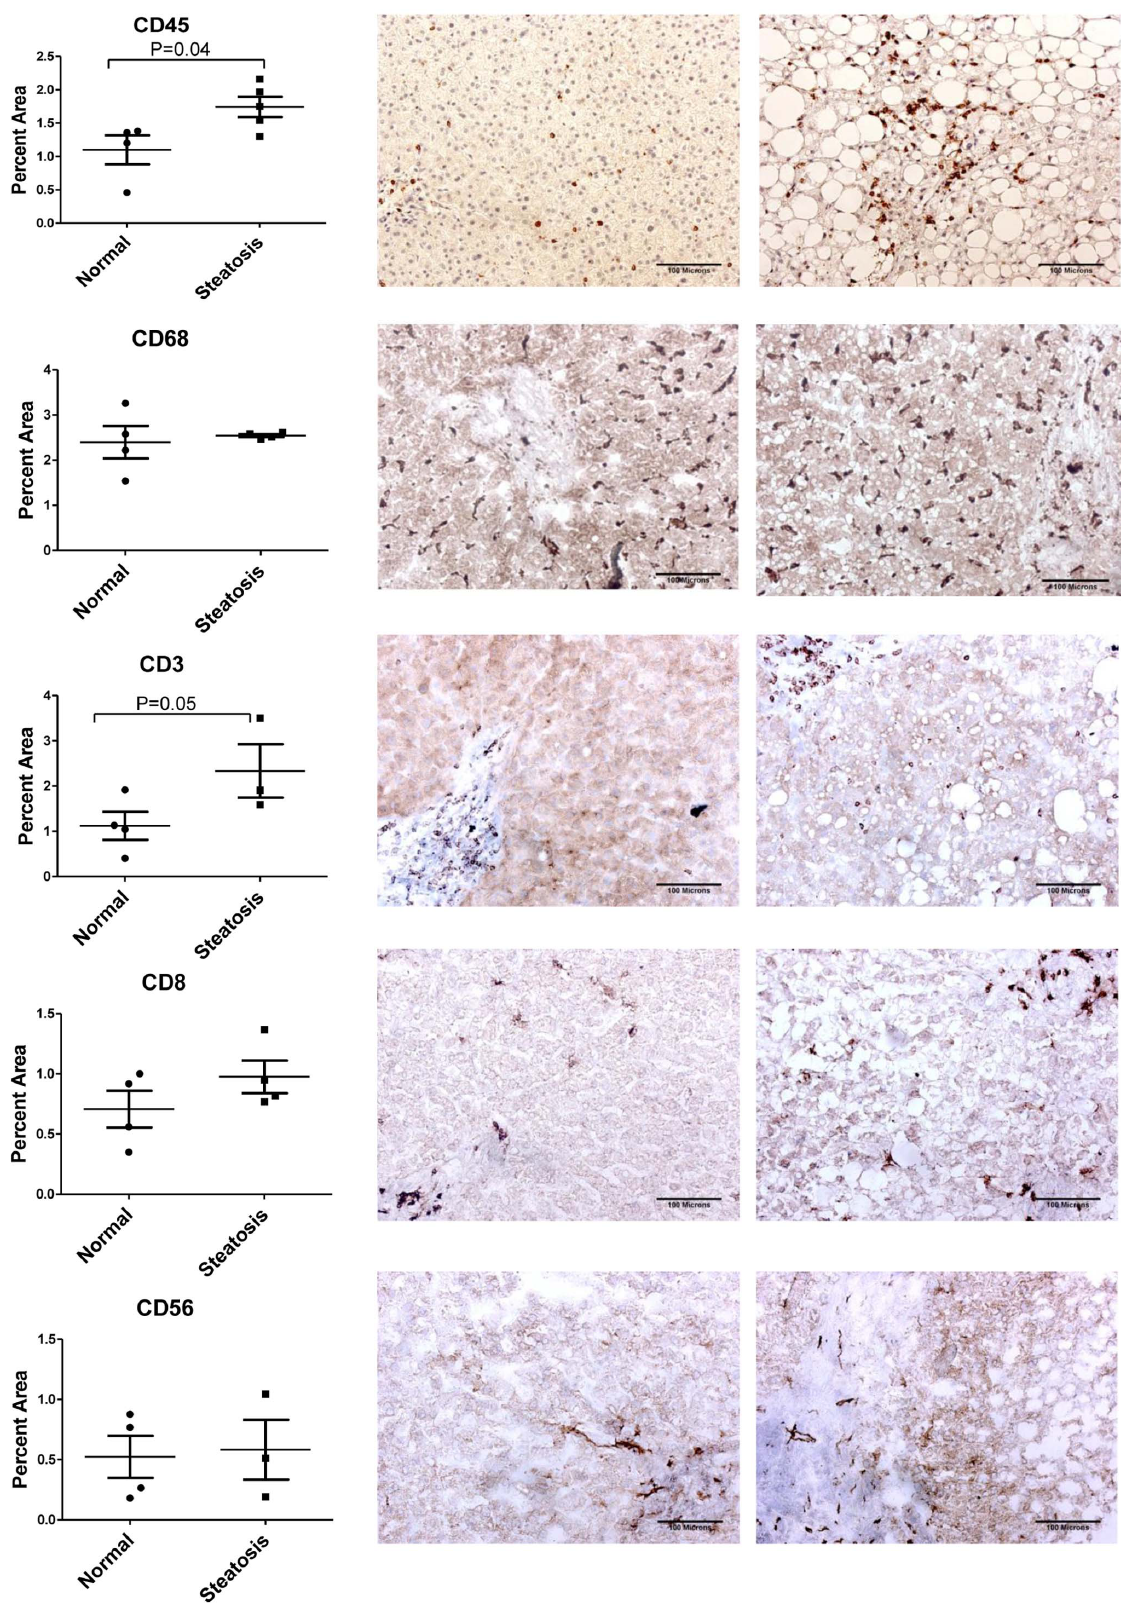
Figure 6. Quantification of inflammatory cell populations in human liver samples. Immunohistochemical staining was used to detect and quantify changes in inflammatory cell populations between normal and steatotic human liver samples. Positive immunoreactive staining (dark